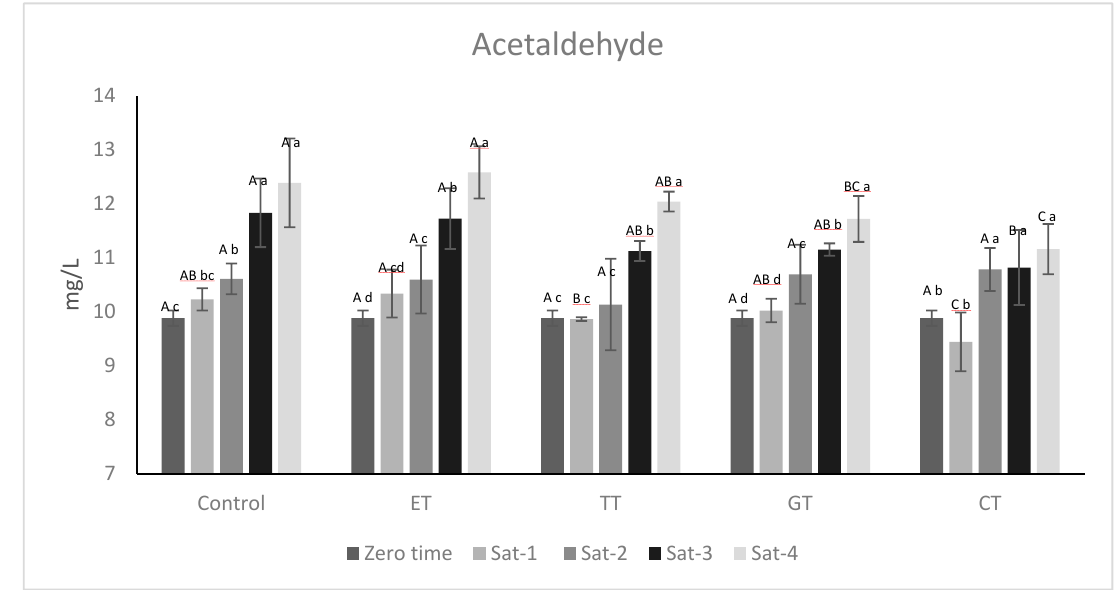
Figure 4. Evolution of acetaldehyde. All the data are expressed as means ± standard deviation. Different letters indicate a statistically significant difference among treated wines during each saturation time (A, B, C, D) and among treated wines for the same saturation time (a, b, c, d). All the data are expressed as means ± standard deviation, (p<0.05).